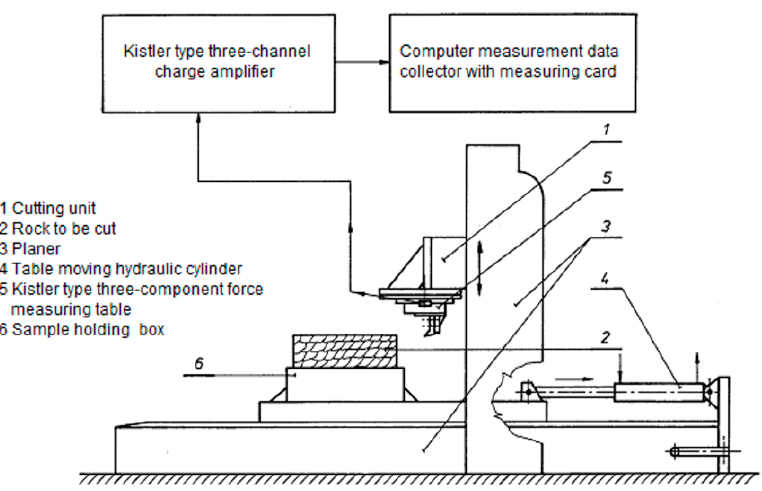
Figure 2. Schematic of the cutting test equipment [12].